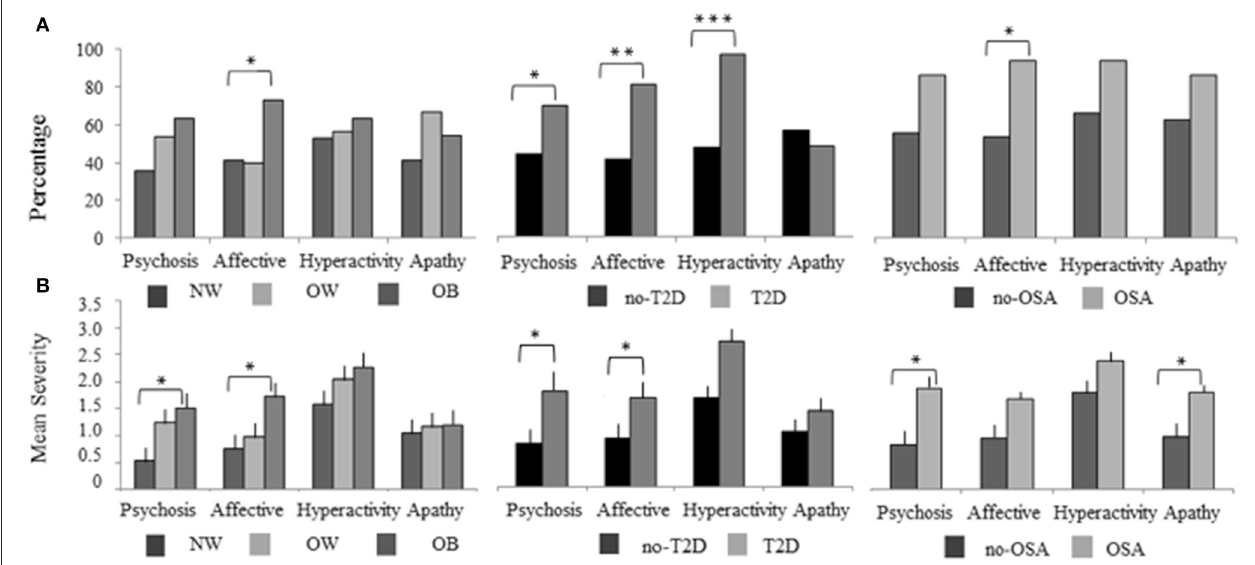
FIGURE 1 | The NPI-Q cluster frequency and severity of BMI, T2D, and OSA MCI subject groups. The 12 NPI-Q symptoms domains are clustered into four groups of, Hyperactivity (agitation, disinhibition, irritability, motor disturbances, and euphoria), Apathy (apathy, appetite), Affective (depression, anxiety) and Psychosis (delusions, hallucinations, night-time behaviors). (A) The frequency of each NPI-Q cluster is plotted for BMI, T2D, and OSA groups. Cluster frequency statistics were conducted using the chi-square test of independence (2 degrees of freedom for BMI and 1 degree of freedom for T2D and OSA). (B) The mean (SE) severity of NPI-Q clusters for BMI, T2D, and OSA groups. Mean differences in cluster severity were compared using the analysis of variance (ANOVA) model for BMI and a Student’s t -test for T2D and OSA. Significant associations are marked as follow, * p < 0.05, ** p < 0.01, *** p < 0.001. NPI-Q, Neuropsychiatric Inventory Questionnaire; MCI, mild cognitive impairment; BMI, body mass index; T2D, type 2 diabetes; OSA, obstructive sleep